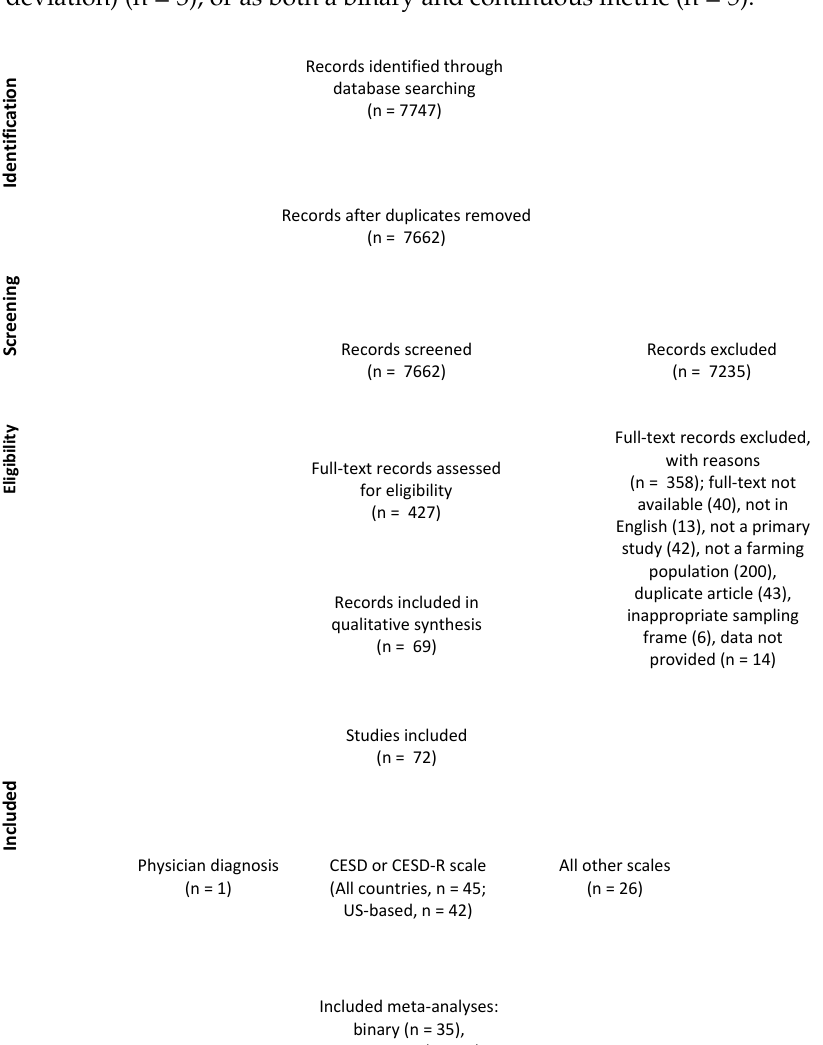
Figure 1. Flow chart reporting the studies included in the systematic review and meta-analysis, determining the prevalence of depression among farming populations.